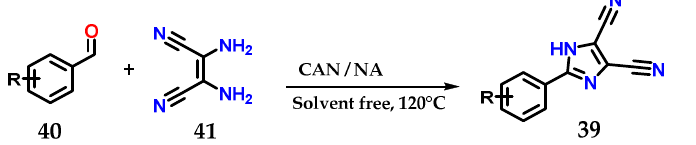
Figure 18. Obtaining 2-aryl-4,5-dicarbonitrile imidazole derivatives 39 using a mixture of CAN:NA as catalysts.